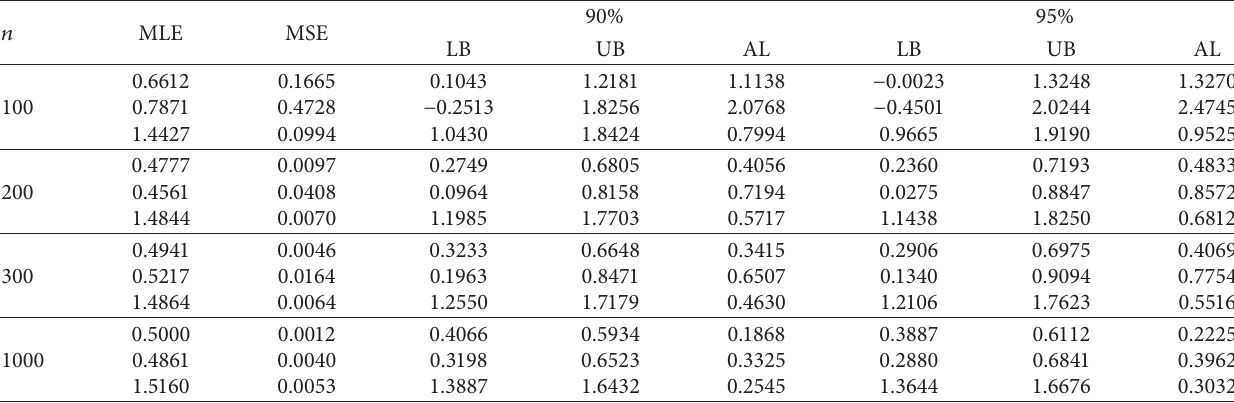
Table 7: Values of the MLEs, MSEs, and elements of CIs associated with the NTMW model parameters for